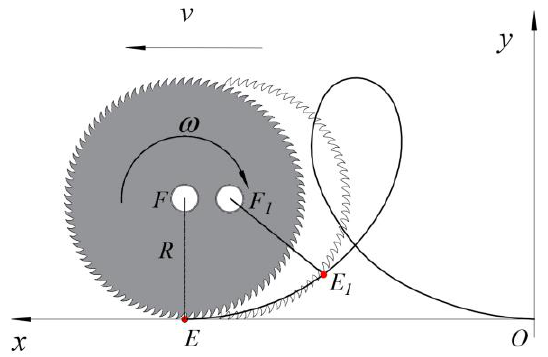
Figure 3. Motion trajectory of the serrated tooth end.